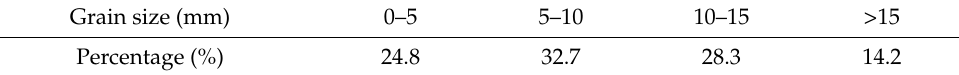
Table 1. Gangue size classification.